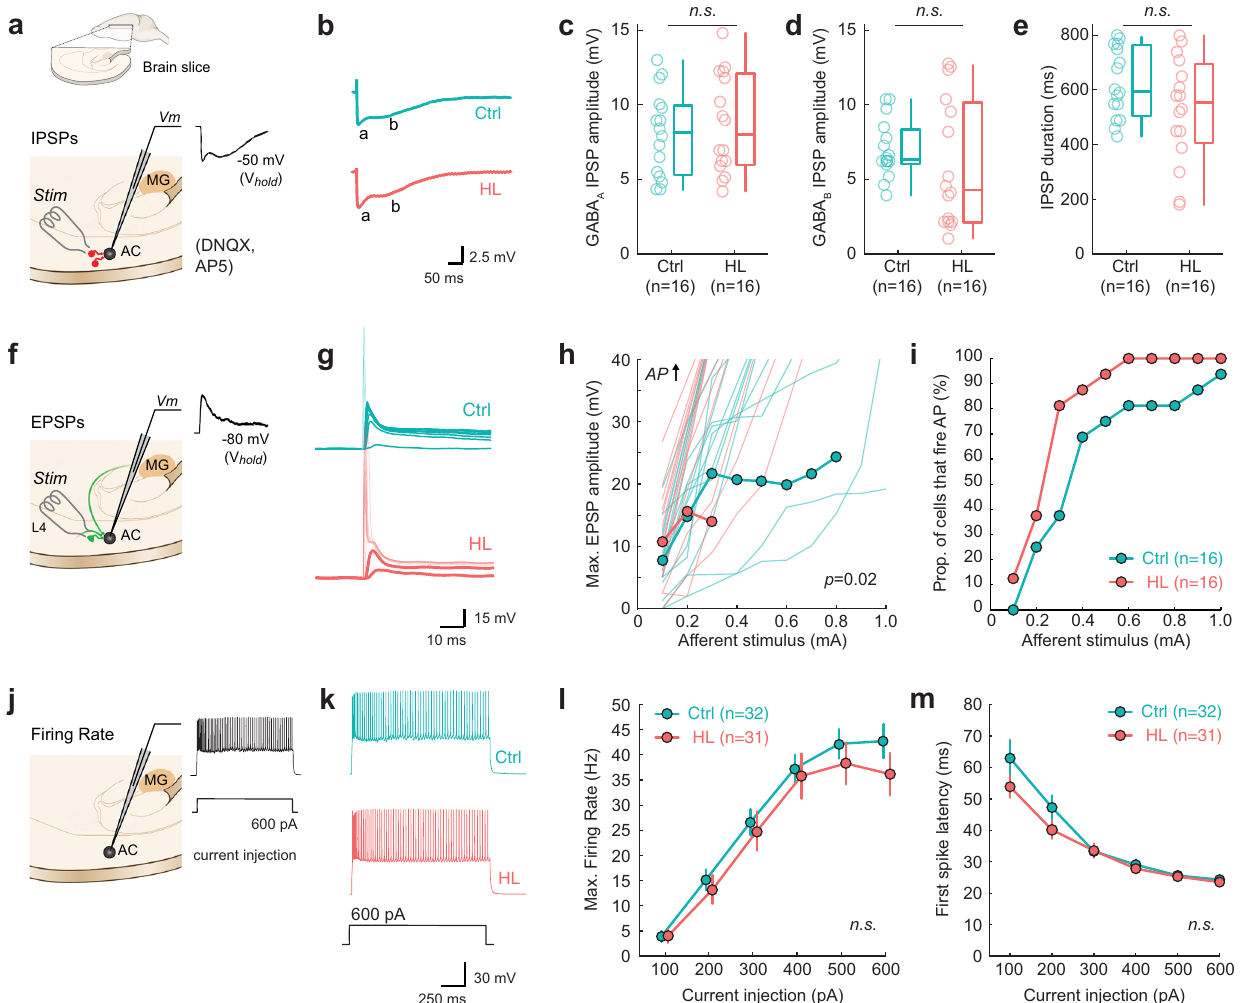
Fig. 7 Hearing loss spanning adolescence induces long-lasting changes to auditory cortical properties. a Schematic of perihorizontal brain slices collected from control ( n = 5) and HL-reared animals ( n = 5; inset). Slices contain the auditory cortex (AC), where recordings from layer 2/3